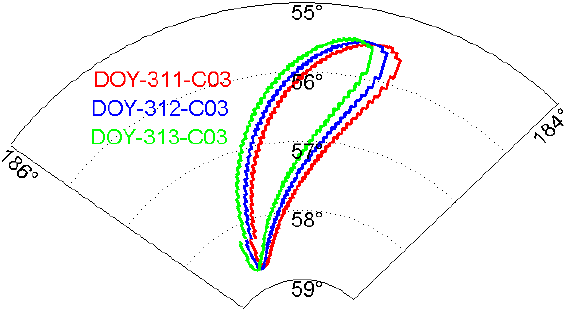
Figure 3. Trajectory of C03 for day of the year (DOY) 311-313 in the elevation and azimuth domain.